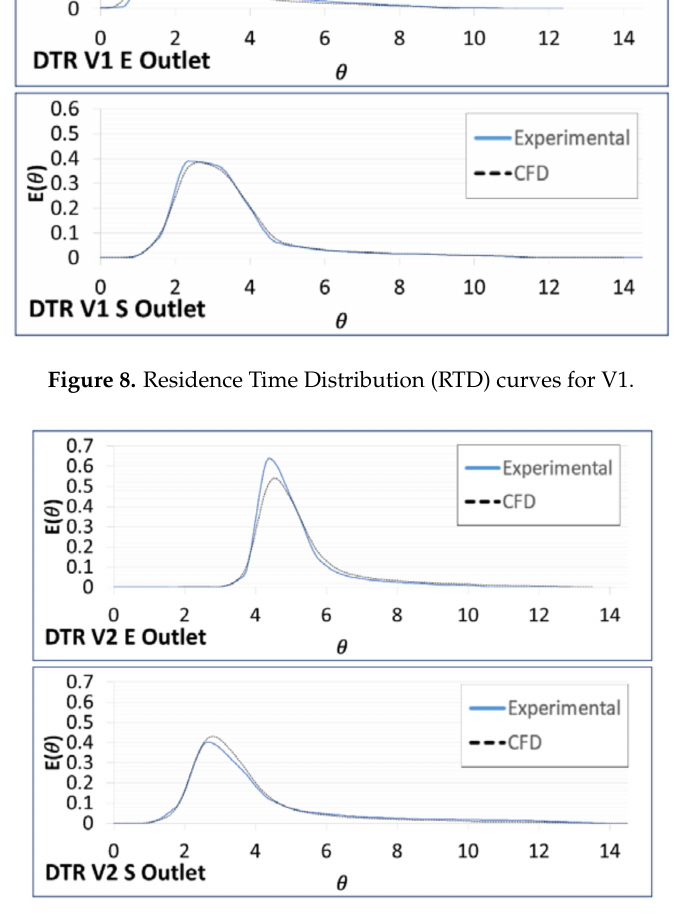
Figure 9. RTD curves for